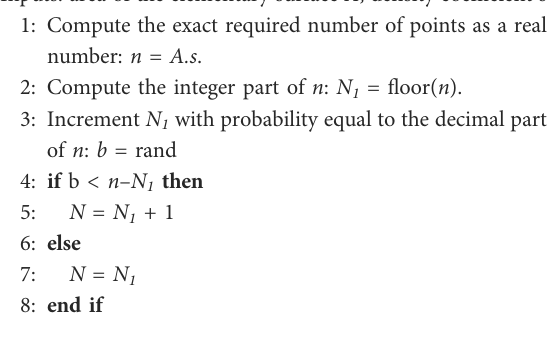
Algorithm 1. Calculating the number of points to be samples from a surface.